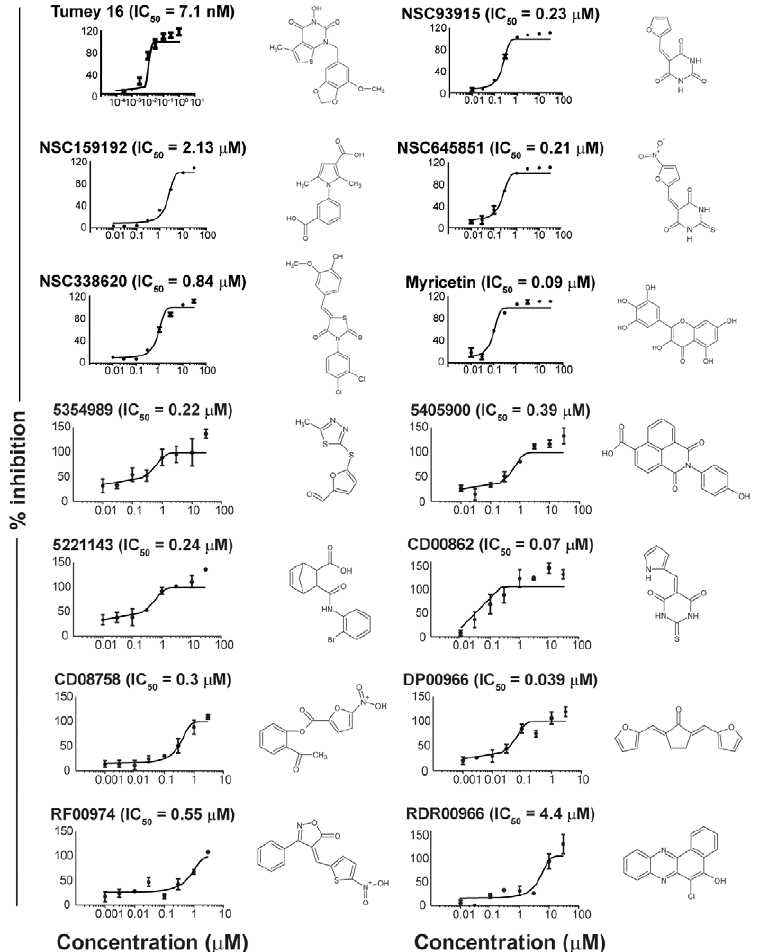
Figure 3. IC 50 curves of flap endonuclease inhibitors. FEN1 assays were carried out as described in Materials and Methods. Compound names are indicated above each graph, and structures are given to the right of each graph. Tumey 16 (top-left panel) was included as a positive control for flap endonuclease inhibition.